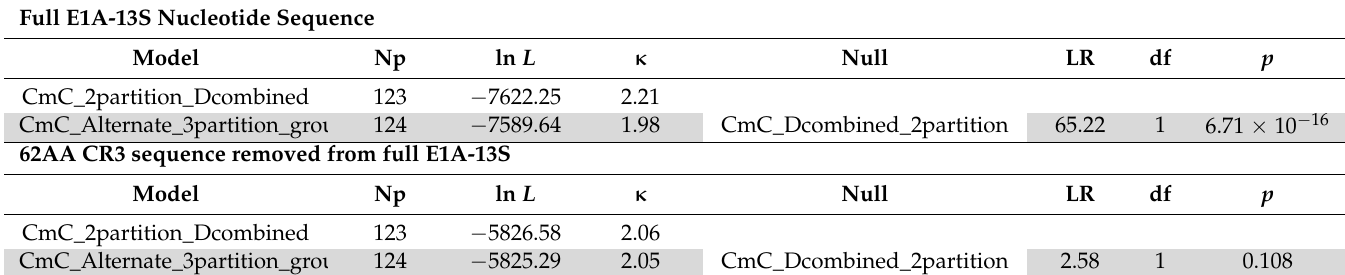
Table 1. Clade model C (CmC) clade divergence